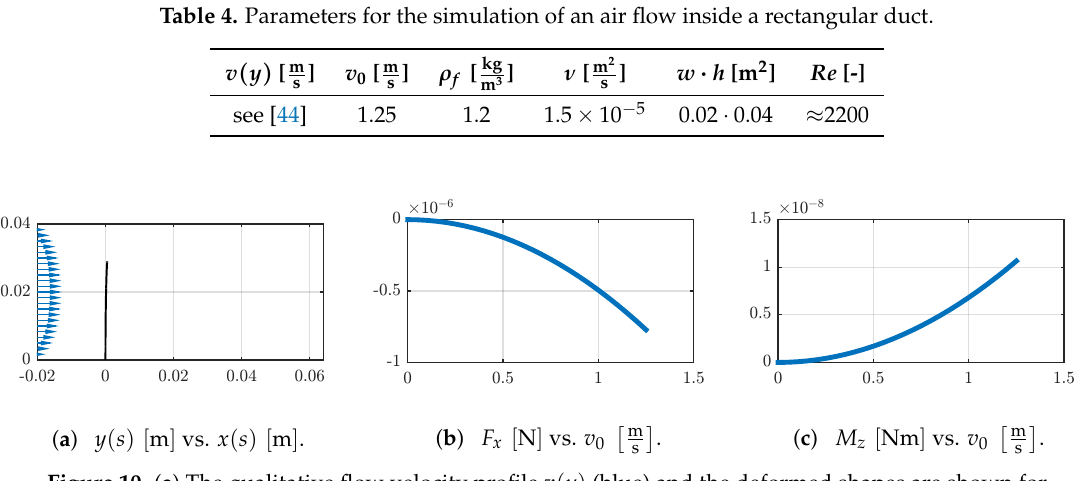
Figure 10. ( a ) The qualitative flow velocity profile v ( y ) (blue) and the deformed shapes are shown for v 0 = 1.25 m . Change of the support reactions ( b ) F x and ( c ) M z in dependence on the flow velocity v 0 s